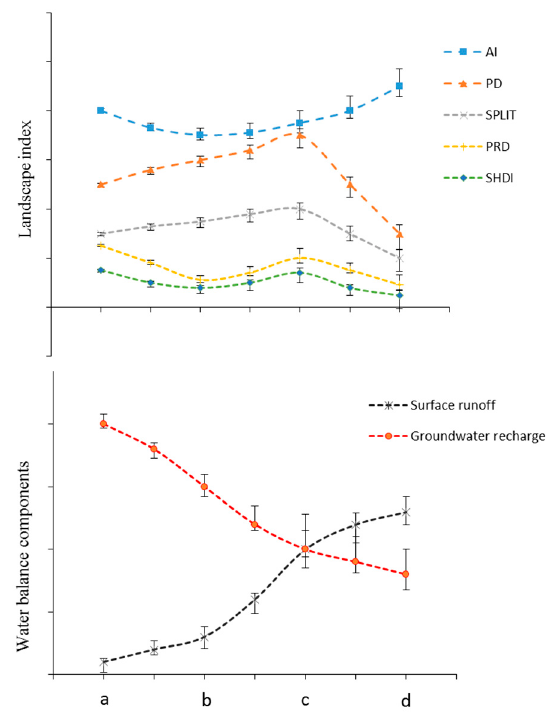
Figure 9. The changing trend of landscape indices and water balance components at four gradients: ( a ) outer suburban; ( b ) suburban; ( c ) suburban transition zone; and ( d ) urban center.